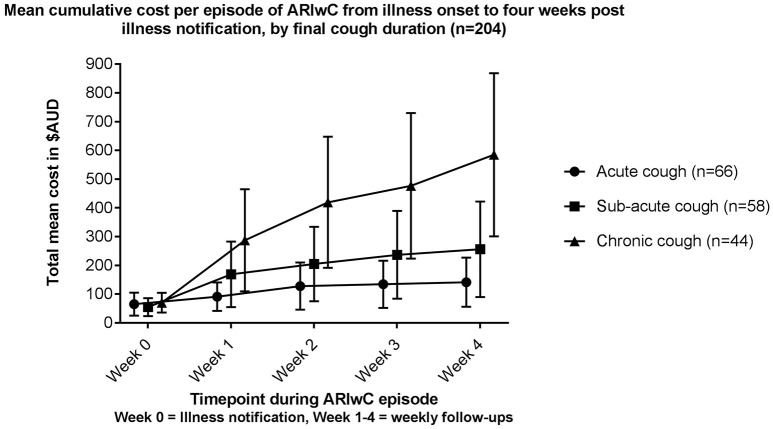
Cumulative cost per episode (means and 95% CI's) of ARIwC from illness onset to 4 weeks post illness notification among episodes requiring weekly follow-ups, by final cough duration (n = 204).